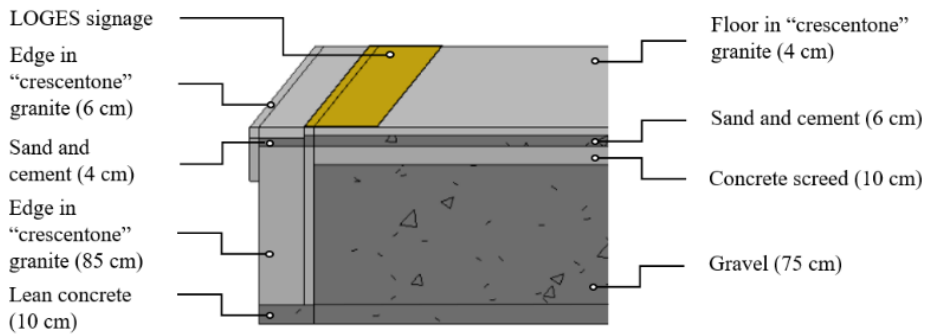
Figure 9. Tram stop platform model by Revit.